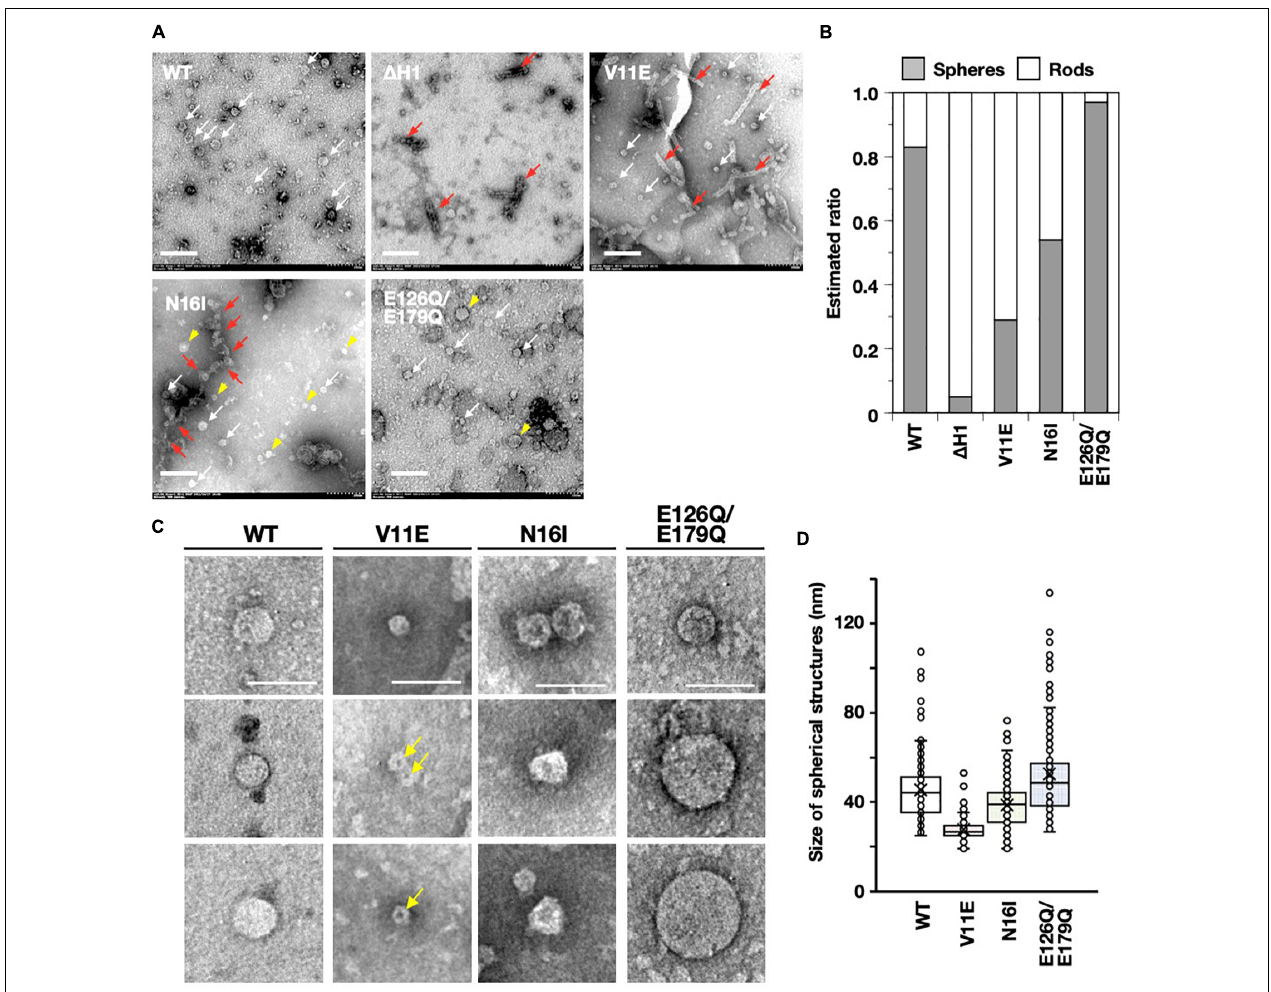
FIGURE 7 | Analyses based on electron micrographs of negative-stained AtVIPP1-His proteins. (A) Typical electron micrographs of wild-type, (cid:49) H1, V11E, N16I, and E126Q/E179Q recombinant proteins. White and red arrows indicate spherical and rod-like structures, respectively. Yellow arrowheads on photos of N16I and E126Q/E179Q point to spherical structures that are characteristic in each species. Scale bars represent 200 nm. (B) The ratio of spheres to rods in each protein preparation was roughly estimated in accordance with the method in Gupta et al. (2021). The details are shown in Supplementary Figure 8A . (C) Examples of spherical structures observed in wild-type, V11E, N16I, and E126Q/E179Q protein preparations. For the three mutants, the upper photos show wild-type-like structures, and the lower two photos represent the structures specifically observed in each mutant. Yellow arrows indicate hole-like shadows located in the center of V11E particles. Scale bars represent 100 nm. (D) Distribution of the size of spherical structures in wild-type, V11E, N16I, and E126Q/E179Q protein preparations. The diameters of 100–280 spherical structures were measured manually, as shown in Supplementary Figure 8B , and plotted on box plot graphs. The distribution of every species of protein differed from each other with p values of < 0.001, which was calculated using the statistical Brunner–Munzel